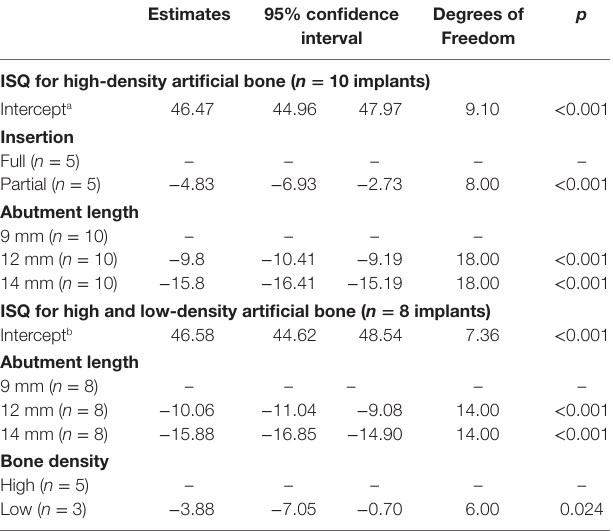
Intercept indicates reference value for implant mounted with 9 mm abutment in high- density bone. – indicates reference variable.